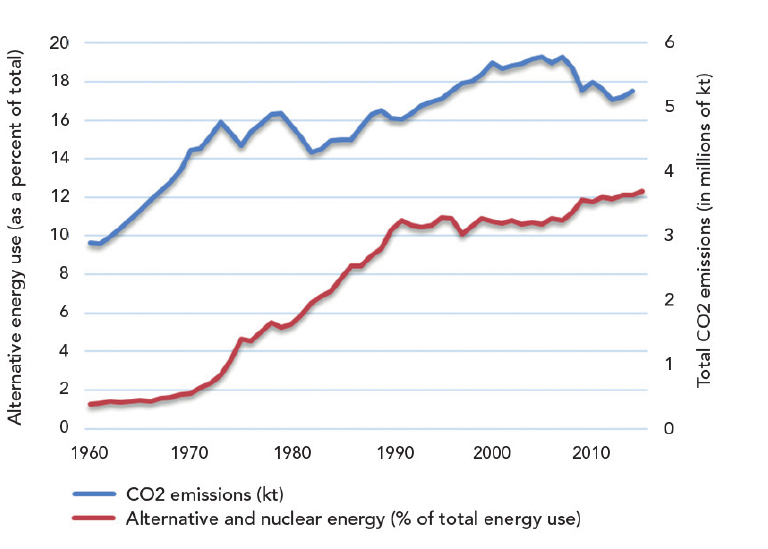
Figure 1 – United States Alternative Energy Use and Total CO2